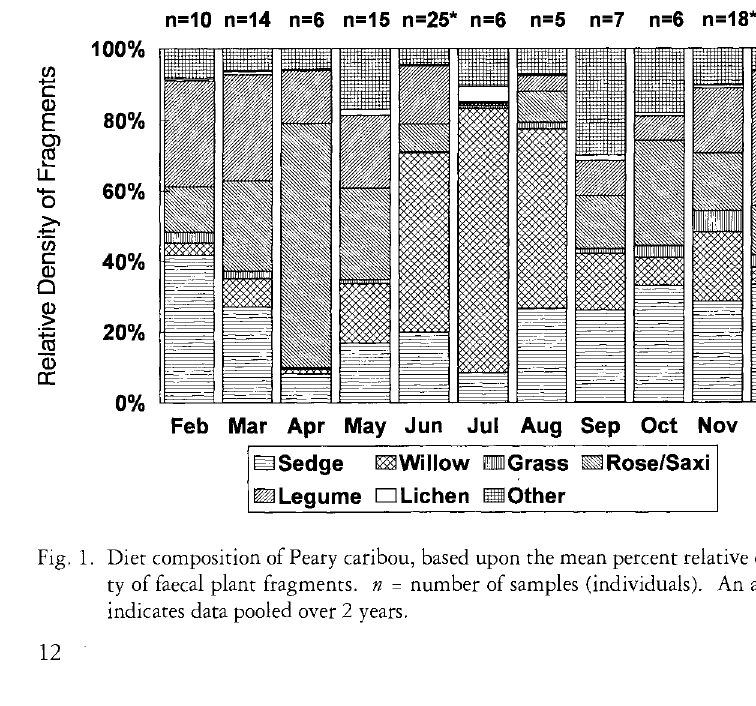
ty. Mean standing crop of legumes, pooled across time and all 3 upland habitats («=228), and D. inte grifolia